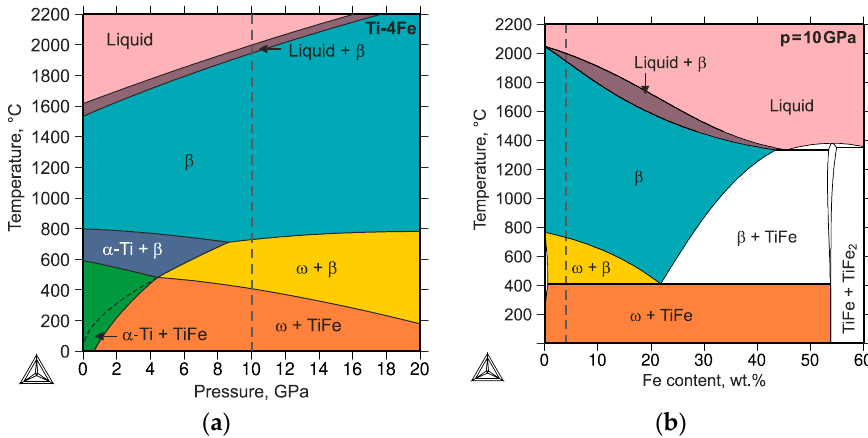
Figure 8. ( a ) Temperature-pressure phase diagram calculated for the composition Ti-4Fe (wt.%) and ( b ) temperature–composition phase diagram calculated for the pressure of 10 GPa. The vertical dashed lines mark the pressure value of 10 GPa (in ( a )) and the alloy composition of Ti-4Fe (in ( b )). The black dashed line in the bottom left corner of panel ( a ) indicates the metastable extension of the β -(Ti,Fe) + ω -Ti(Fe) region.